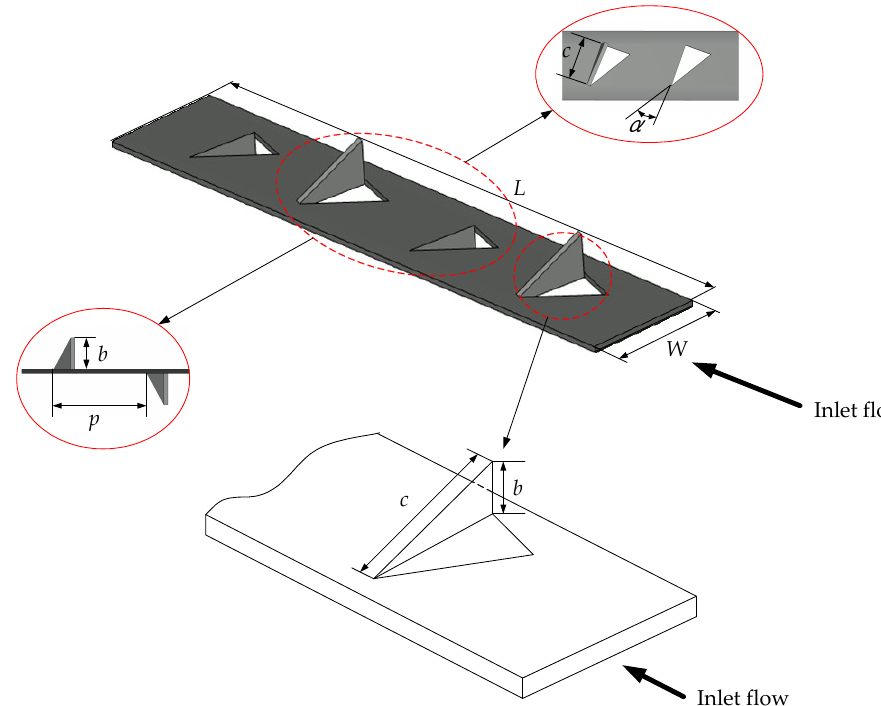
Figure 3. Schematic diagram of double-sided delta-winglet vortex generators.